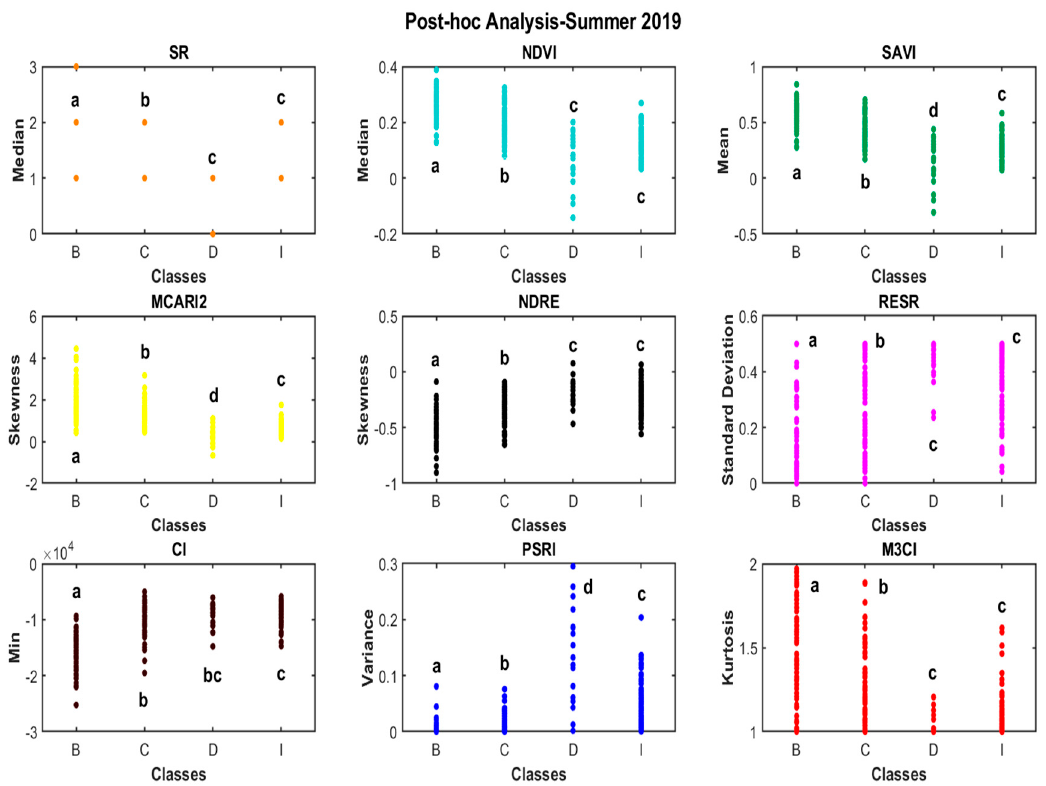
Figure 8. Post-hoc analyses for vegetation indices (VIs) showing the strength of association between the four major categorical classes (healthy broadleaves = B, healthy conifers = C, infested conifers = I, dead conifers = D) and the most significant descriptive statistics for each VI. Small letters (a–d) were used to denote significant di ff erences between groups ( p -value <